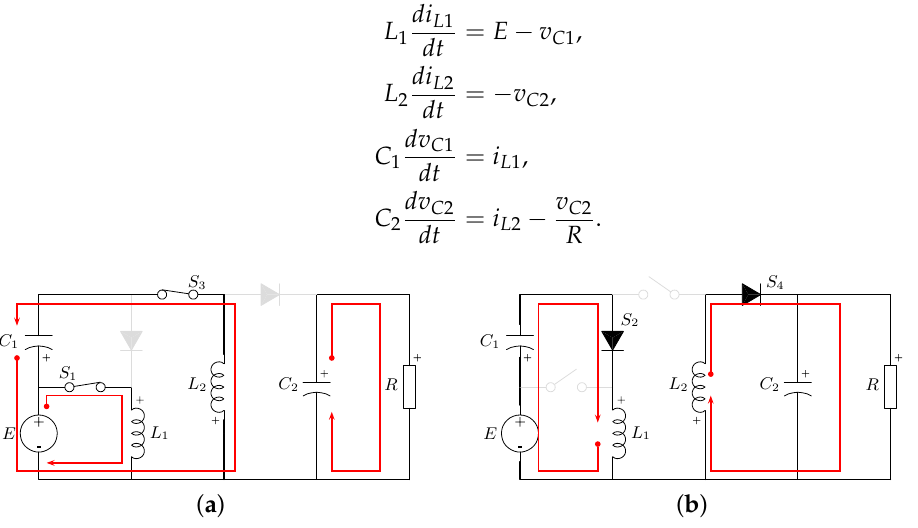
Figure 4. Operating modes of the proposed converter: ( a ) function q = 1; ( b ) function q = 0. The set of Equations (2) and (3) defines the voltages at the terminals of the inductors and the currents through the capacitors in one switching period. For these voltages